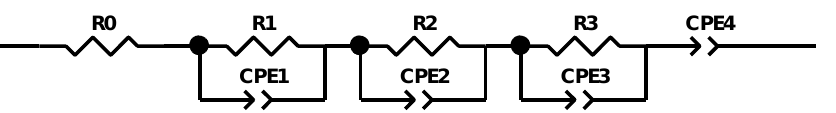
Figure 9. Equivalent electrical circuit simulating the impedance spectra of Si/C electrodes. The first element R 0 represents all the ohmic resistances of the system, including the resistance of the electrolyte. The next three blocks are parallel combinations of resistance and element with a constant phase shift ( R 1 (cid:107) CPE 1 ), ( R 2 (cid:107) CPE 2 ) and ( R 3 (cid:107) CPE 3 ). The first two blocks model a semicircle, which is in the region between 100 kHz and 4 Hz and represents the superposition of one semicircle on another. The data obtained indicate the existence of two processes that govern charge transfer through the solid electrolyte layer. Thus,